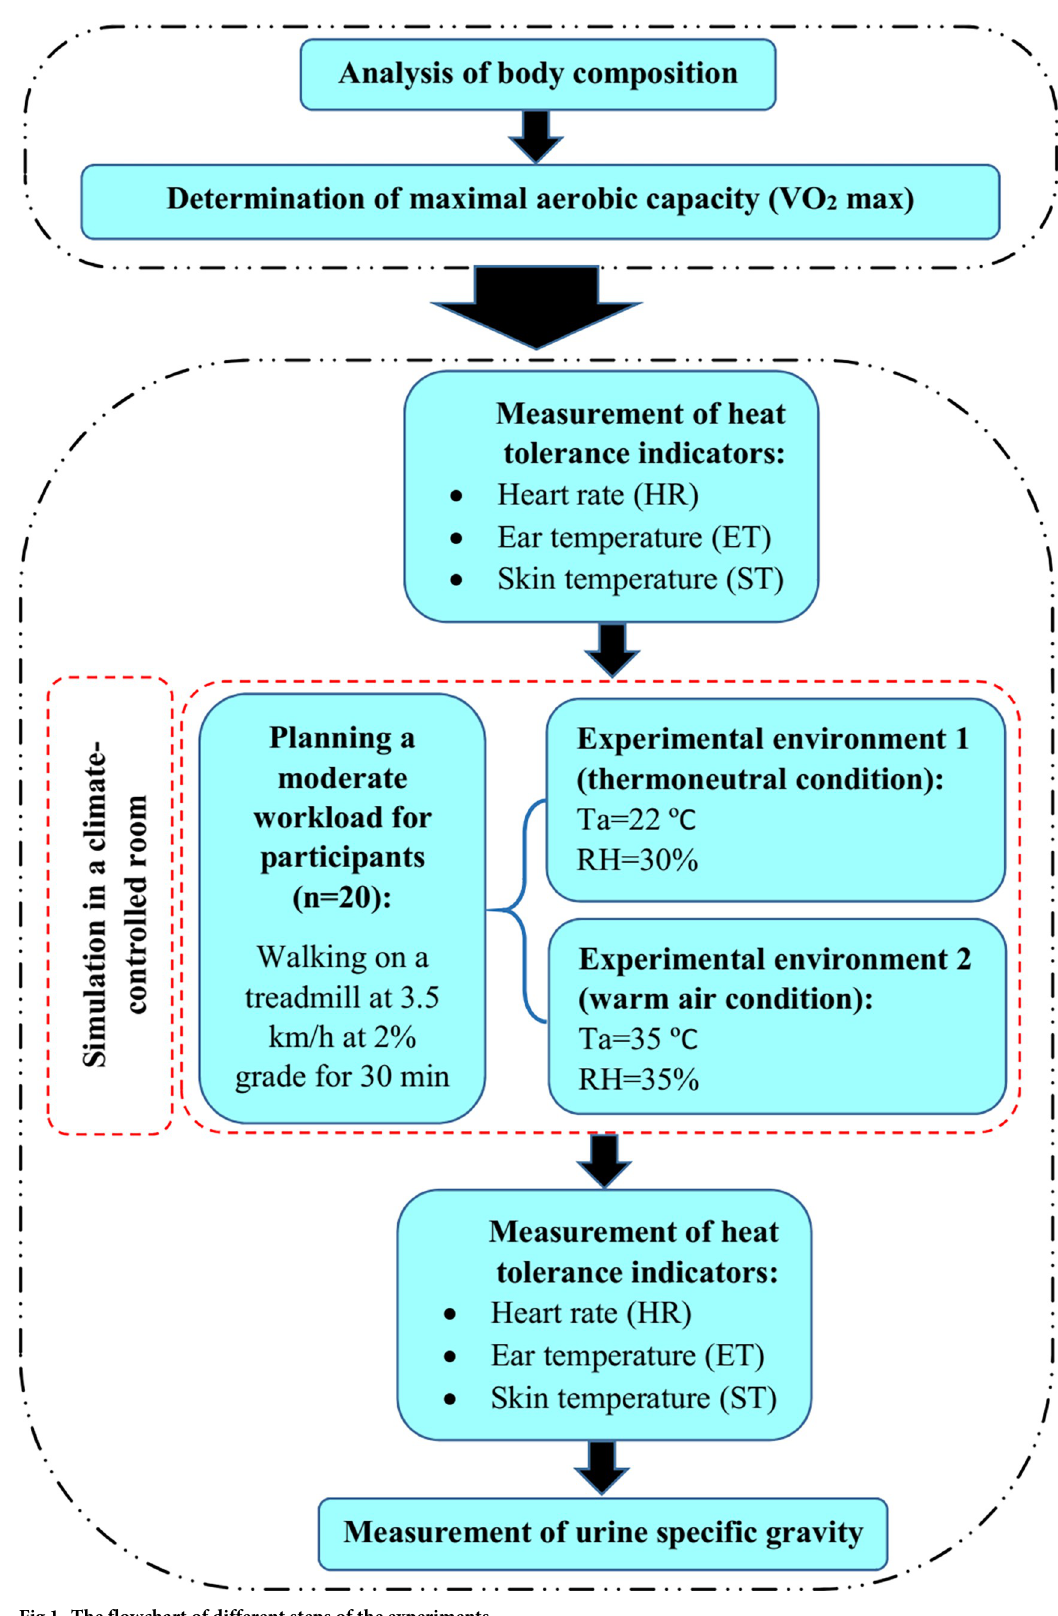
Fig 1. The flowchart of different steps of the experiments. https://doi.org/10.1371/journal.pone.0279170.g001 PLOS ONE | https://doi.org/10.1371/journal.pone.0279170 December22,